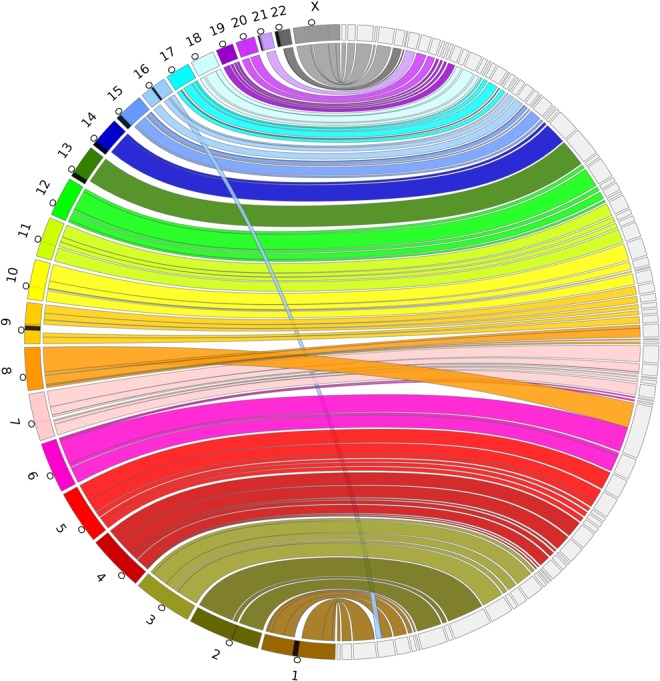
A Circos (Krzywinski et al. 2009) assembly consistency plot. Scaftigs from the largest 89 scaffolds that compose 90% of the genome are aligned to GRCh38 using BWA-MEM. GRCh38 chromosomes are displayed on the left and the scaffolds on the right. Connections show the aligned regions between the genome and scaffolds. Contigs are included as a part of the same region if they are within 1 Mbp on either side of the connection, and regions <100 kbp are not shown. The black regions on the chromosomes indicate gaps in the reference and the circles indicate the centromere location on each chromosome.